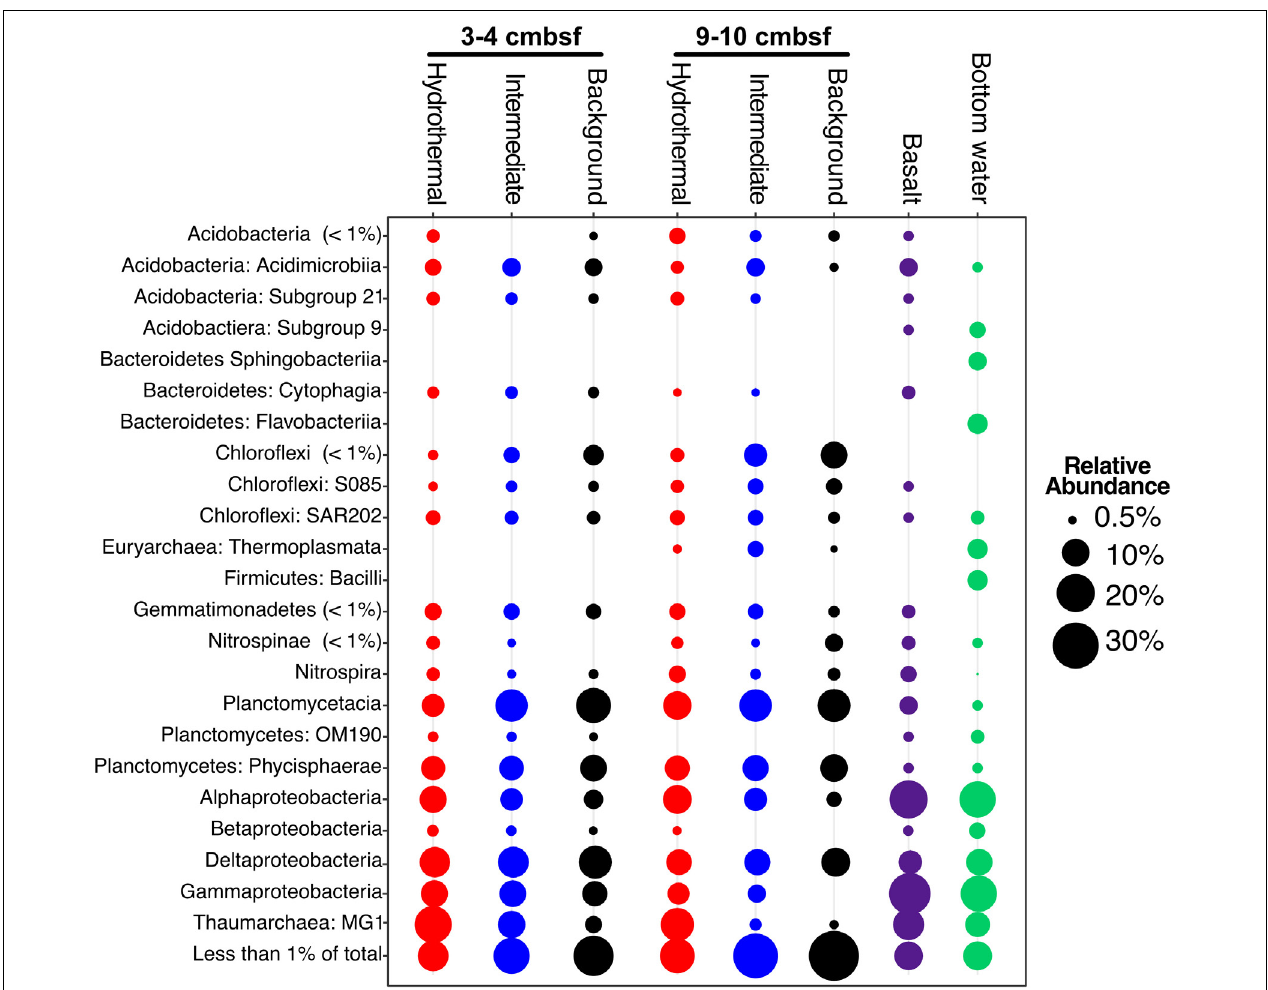
FIGURE 3 | Taxonomic abundance of classes over 1% of the total community in Dorado Outcrop sediment, basalt, and bottom seawater samples based on 16S rRNA gene sequencing using the EMP primer pair (515F – 806R). Basalts and bottom seawater data from Lee et al.